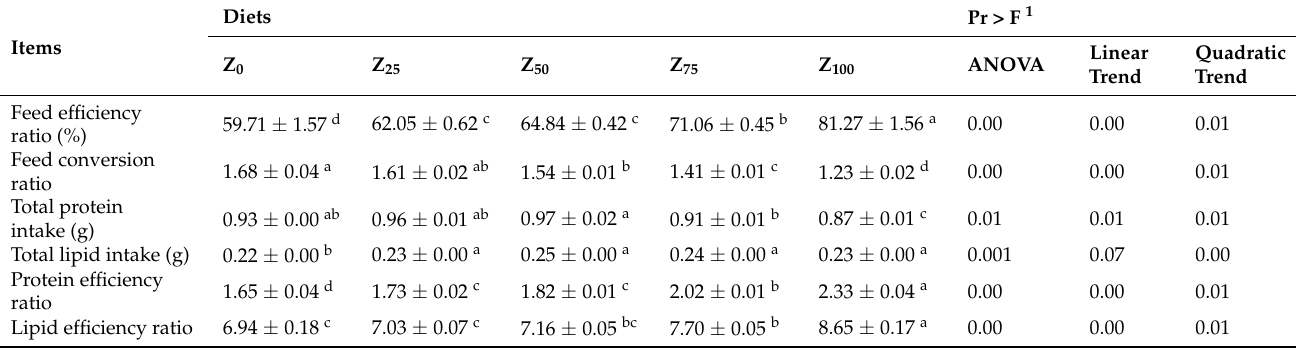
Table 5. The approximate composition (% on dry matter basis) of whole-body of grey mullet, Mugil cephalus , fed experimental diets for 60 days. Table 4. Feed utilization of grey mullet, Mugil cephalus , fed experimental diets for 60